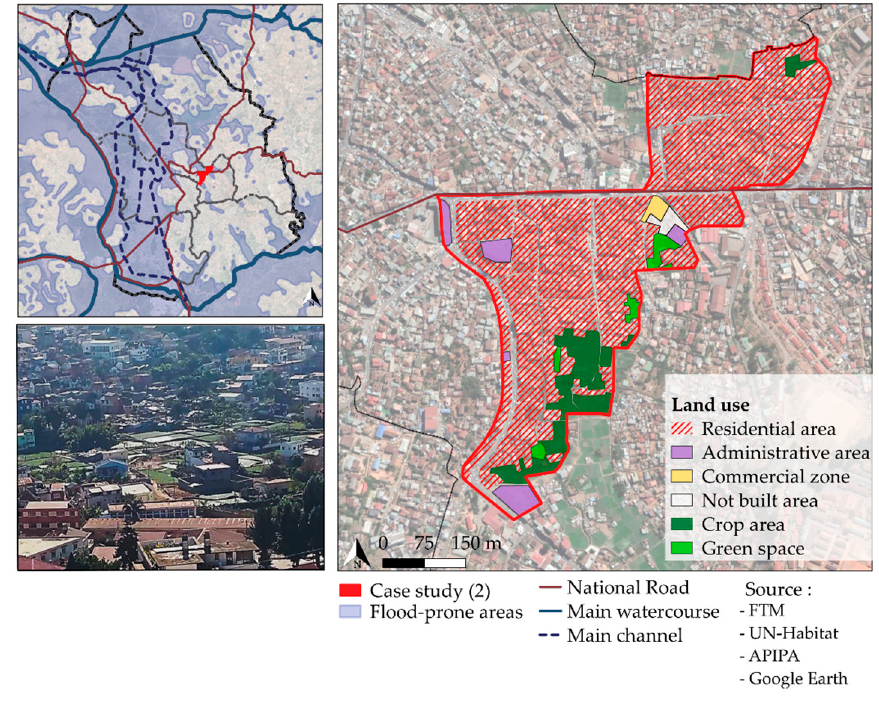
Figure 11. Map of Fokontany of Ampandrana-Besarety and Besarety in